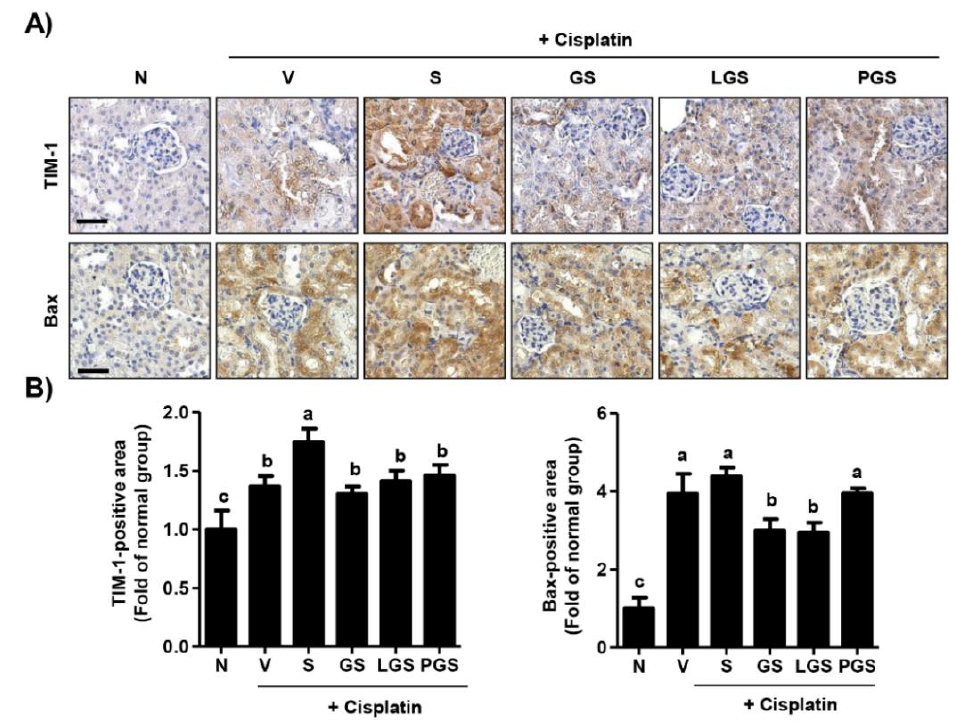
Figure 3. Effect of GABA salt on renal cell death in cisplatin-induced acute nephrotoxicity. ( A ) Intra-renal expression of T-cell immunoglobulin and mucin domain 1 (TIM-1) and Bcl2- associated X (Bax). Scale bar = 100 µ m. ( B ) Quantitative analysis for positive area of TIM-1 and Bax. Data are expressed as means ± SD ( n = 4). a–c Bars with different letters are significantly different at p < 0.05 by Tukey test. N, normal group; V, cisplatin + saline group; S, cisplatin+ 4% high salt group; GS, cisplatin + high salt containing GABA group; LGS, cisplatin + 4% sodium containing lacto GABA salt group; PGS, cisplatin + 4% sodium containing postbiotics GABA salt group.